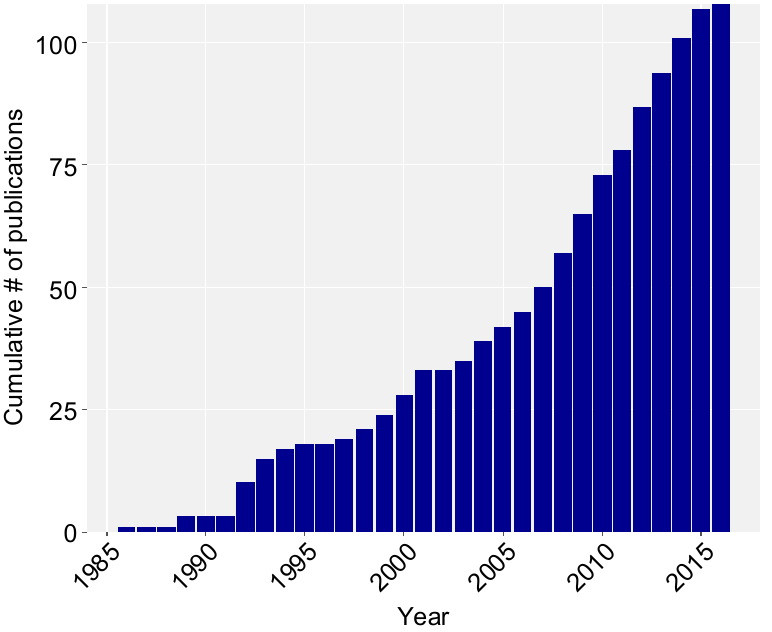
Figure 1. Cumulative studies ( n = 108) by publication year that relate to participation in nature-based activities by Latino communities. Studies include those that focused solely on Latino populations as well as cross-ethnic comparisons that included Latinos.